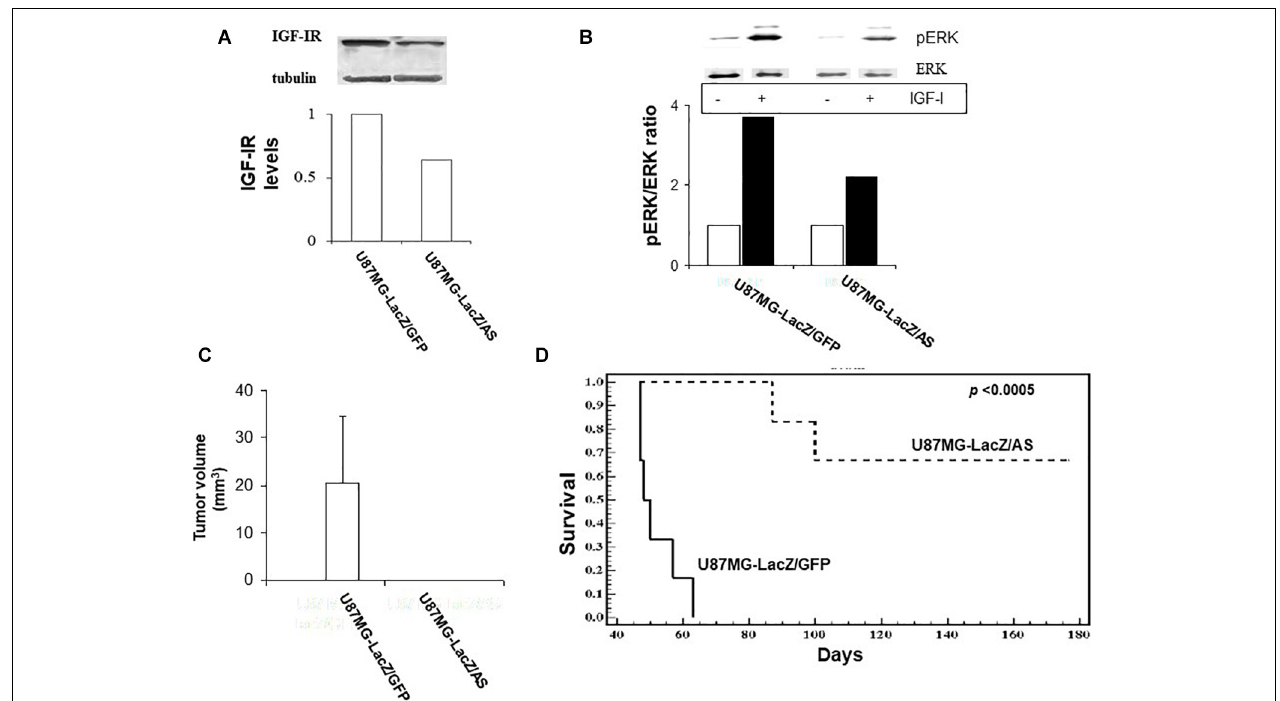
FIGURE 6 | Reduced IGF-IR expression in virally transduced U87MG cells inhibits IGF-I responsiveness in vitro and tumor growth in vivo . U87 cells were transduced with vLTR-IGF-IR AS or vLTR-GFP particles. IGF-IR levels were analyzed by Western blotting (A) . Shown are the results of a representative blot ( n = 2). Results of the laser densitometry, shown in the bar graph are expressed as the ratios of IGF-IR:tubulin relative to U87MG-LacZ/GFP cells which were assigned a value of 1. ERK phosphorylation (B) was measured following the incubation of serum-starved tumor cells with 100 ng/ml IGF-I for 10 min. Blots were probed consecutively with antibodies to phospho-p44/42 ERK and p44/42 ERK. Shown are the results of one representative experiment of two performed. Results in the bar graph are expressed as mean increase in pERK:ERK ratios relative to control, untreated cells (analyzed in the same gel) that were assigned a value of 1 ( n = 2). Nude mice were injected intra-cranially with 10 5 U87 cells as indicated. Tumor volumes (C) were measured on day 35 post injection and survival (D) was analyzed in separate groups of mice injected as above. Shown in (C,D) are pooled data from two separate experiments, each performed with 6 nu/nu mice per group. ∗ p <